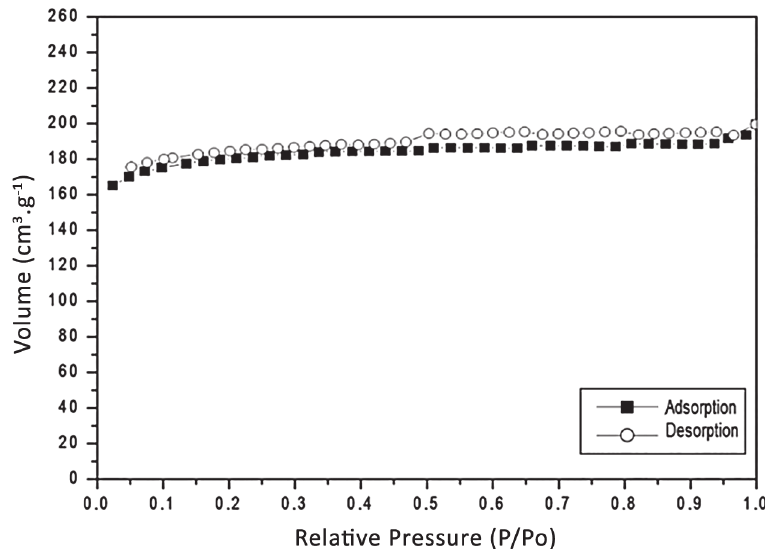
.Figure 3 - Isotherm of AVF sample under N